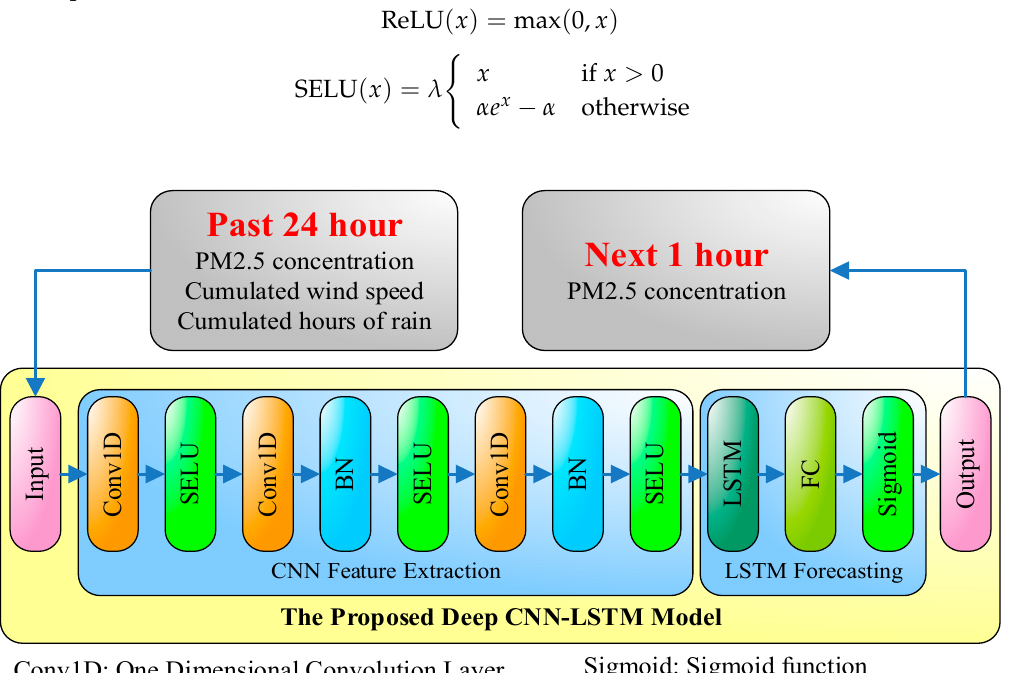
Figure 5. The architecture of the proposed APNet.